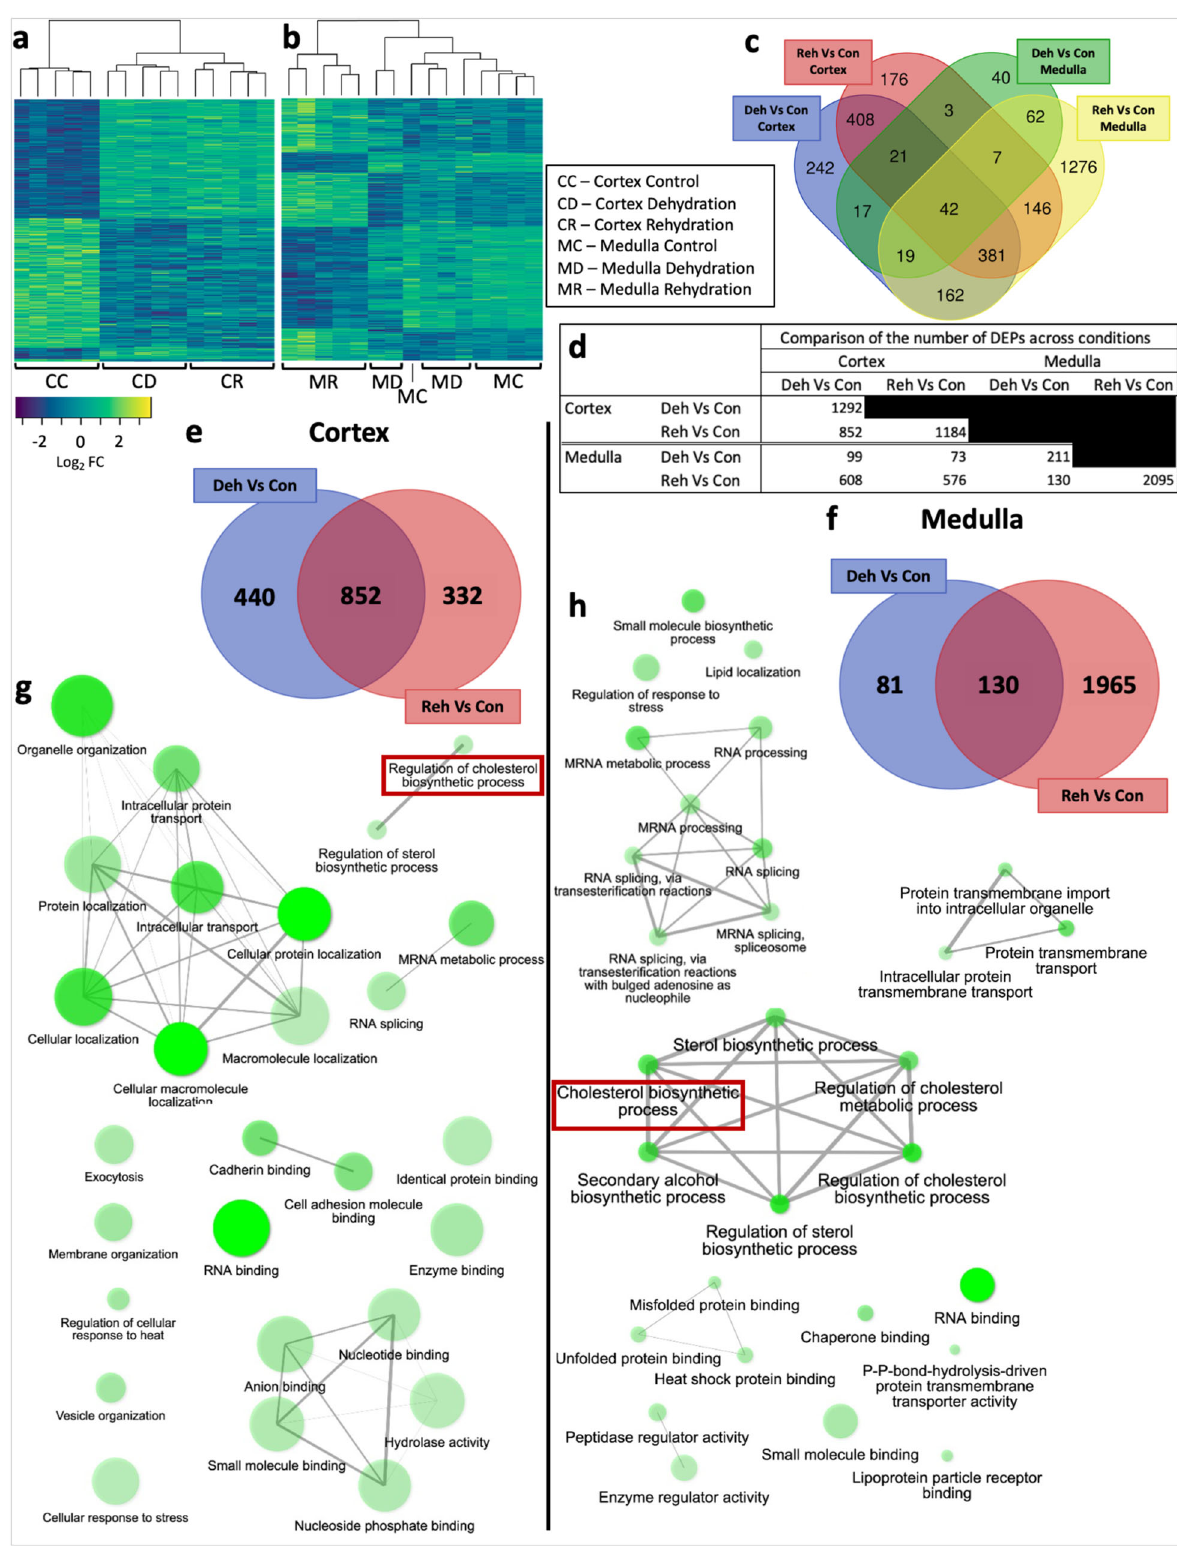
good reproducibility, we did not fi nd signi fi cant differences between the cortex and the medulla nor across conditions. Cholesterol levels were similar in both tissues, with 1.00 ± 0.21 and 0.90 ± 0.19 µg/mg ( n = 15) of cholesterol measured in cortex and medulla,